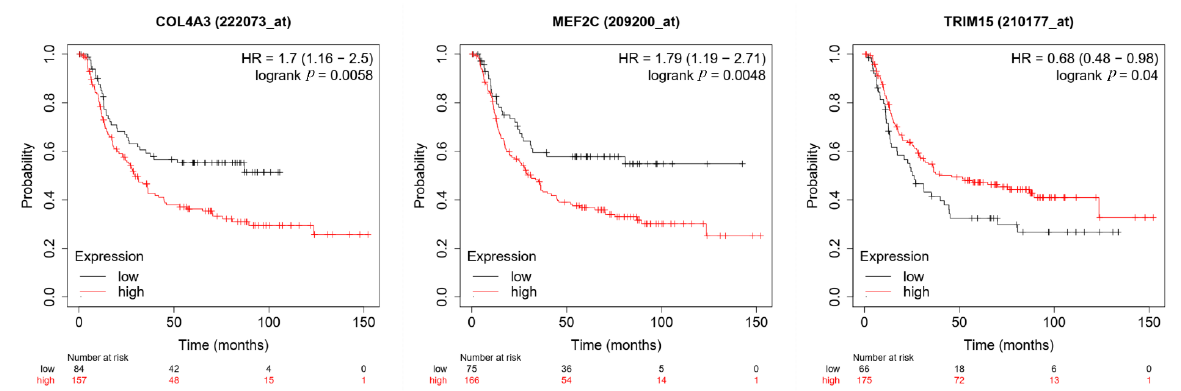
Figure 3. Validation of prognostic value of three genes in diffuse-type gastric cancer (n = 241) by Kaplan – Meier Plotter. Kaplan–Meier